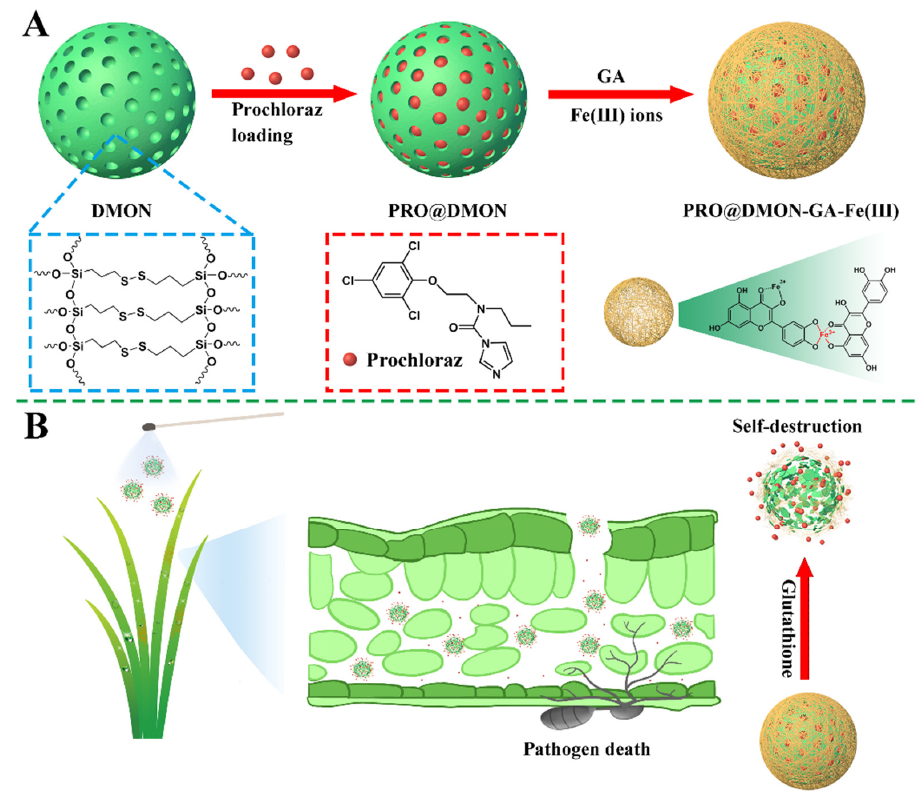
Figure 1. The mechanism for preparation of PRO@DMON–GA–Fe(III) nanoparticle ( A ). The trig- gered release mechanism of prochloraz from PRO@DMON–GA–Fe(III) nanoparticles ( B ). release mechanism of prochloraz from PRO@DMON–GA–Fe(III) nanoparticles ( B ).